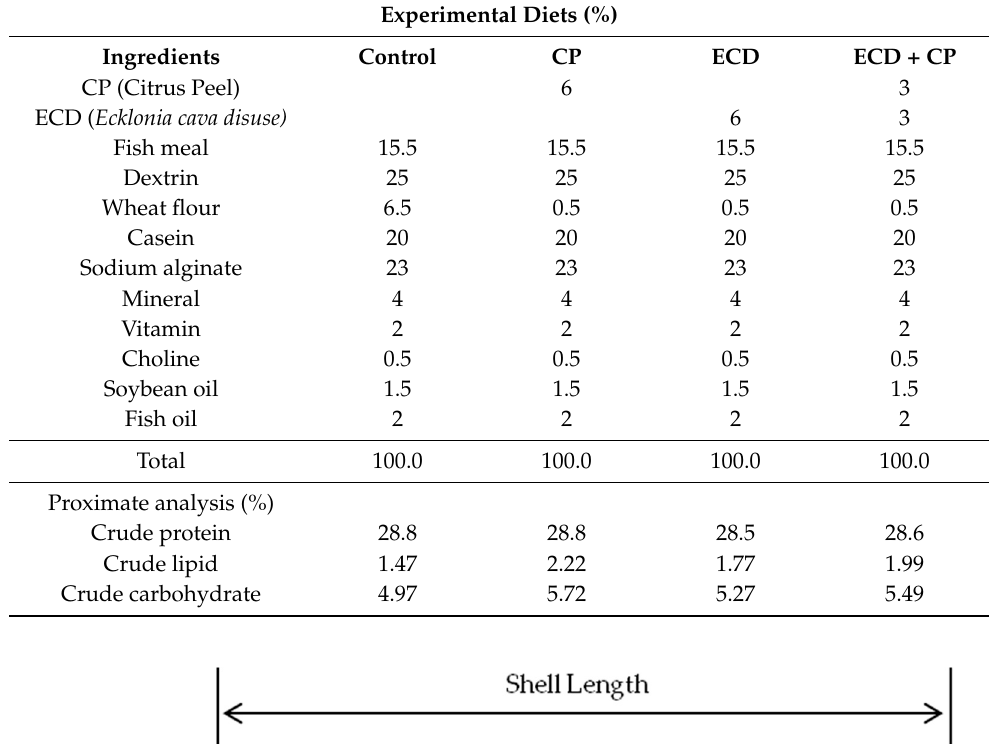
Table 1. Ingredients (%) of the experimental diets.